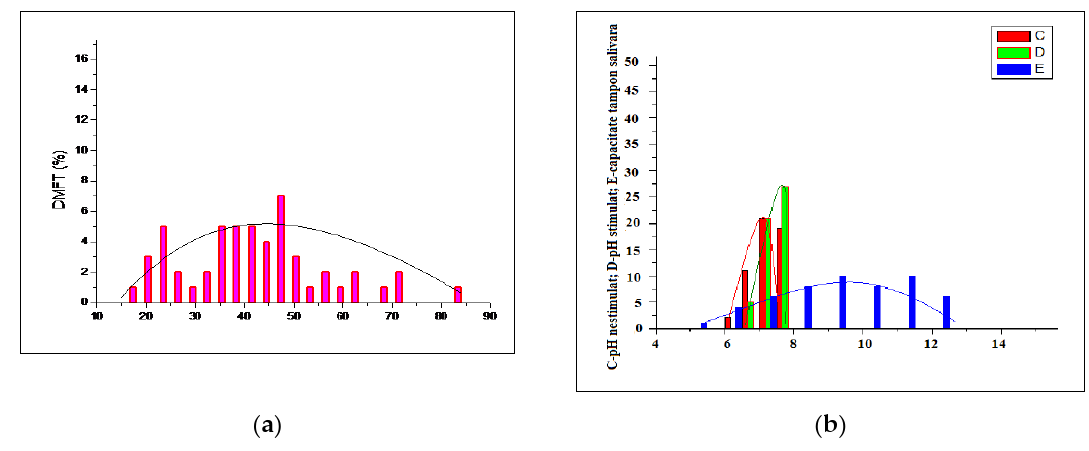
Figure 10. Histograms of the distributions of values for parameters: ( a ) DMFT (%); ( b ) unstimulated pH (C), stimulated pH (D), salivary buffer capacity